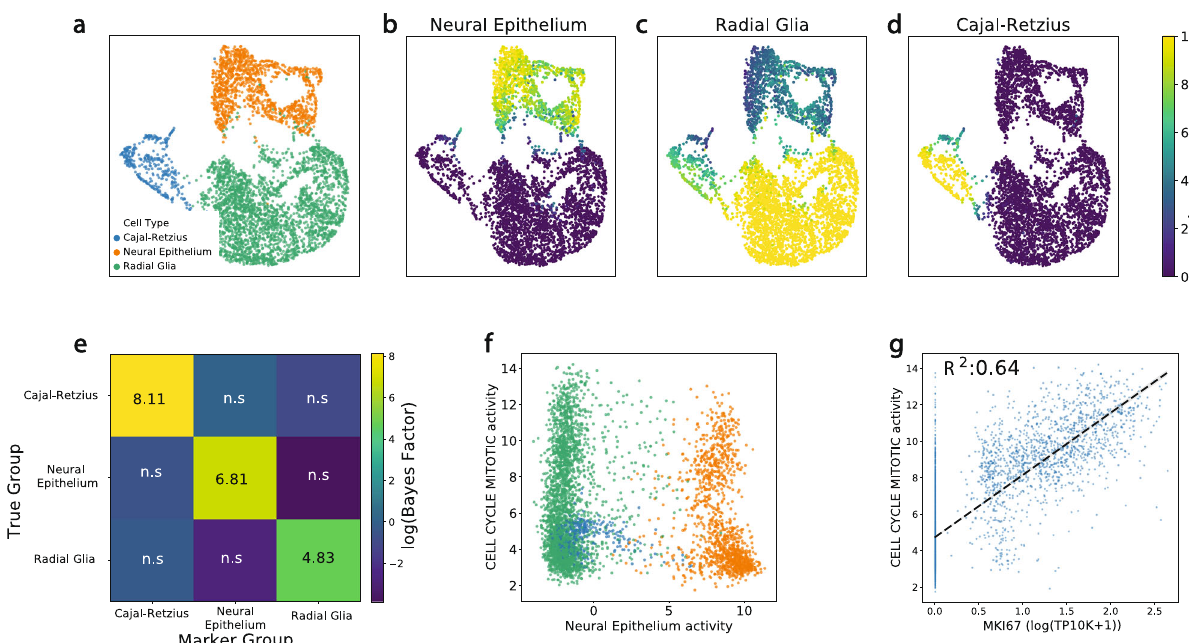
Fig. 3 Disentangling cellular states and cell types in the early development of cortical organoids. a UMAP embedding of the latent space of our model for the week 2 cortical organoid dataset 31 . The cell type annotation corresponds to the original paper annotation. b , c , d The inferred activity of each cell type GMVs (as de fi ned by marker genes) correctly identi fi es the three main subpopulations of cells. e One-vs-rest differential GMV analysis of each cell type population provides a statistical signi fi cance for each cell type signature. The signi fi cance threshold for positive enrichment was set to log e (BF)> 3. f Identi fi cation of dividing and quiescent subpopulations of neural progenitors using pathway and cell-type activity projection. g CELL_CYCLE_MITOTIC pathway activity correctly identi fi es dividing cells as reported by its correlation with MKI67 gene expression (an external canonical marker of dividing